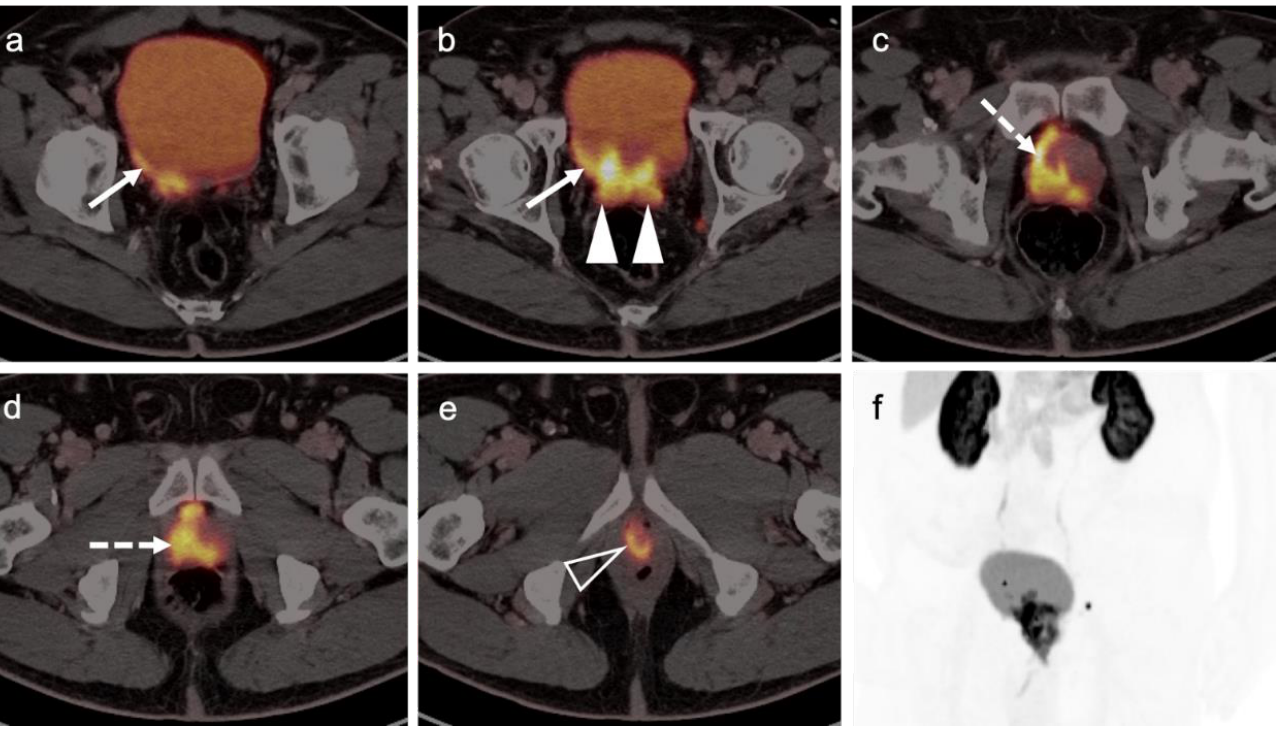
Figure 31. Extensive extra-prostatic spread of prostate cancer on PSMA PET-CT. Areas of tumor include ( a , b ) spread into the urinary bladder (white arrows); ( b ) involvement of both seminal vesicles (solid white arrowheads); ( c , d ) extensive involvement of the prostate; ( e ) encasement of the proximal urethra (open white arrowhead); ( f ) MIP PSMA PET mage of the pelvis shows the extensive extra-prostatic involvement and two small involved bilateral pelvic lymph nodes.